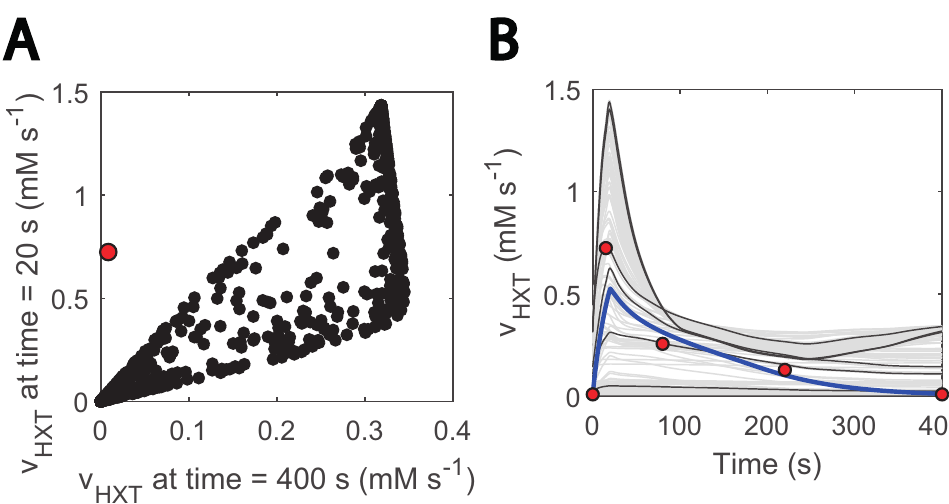
Figure 6. Glucose sensing is needed to explain HXT kinetics: ( A ) glucose uptake rate at 20 s vs at 400 s; 20 s is the approximate point for the maximum reaction rate. Black data show simulations generated with randomly generated parameter samples when no threshold value is considered. A total of 1000 samples were run within 3 orders of magnitude above and below the estimated parameters. Parameters were randomized for HXT kinetics, and external glucose concentration was fit to the experimental data; ( B ) visualization of hexose transport rate during the cycle for the abovementioned models; the blue line corresponds to the simulation with the model considering glucose sensing. The grey and black coloured simulations are the ones with the generated models. Only 200 are displayed and some simulations are highlighted in black to ease visualization. The red dots point to the experimental data points. The individual effect of HXT kinetic parameters ( V max , K M ) can be found in Supplementary Figure